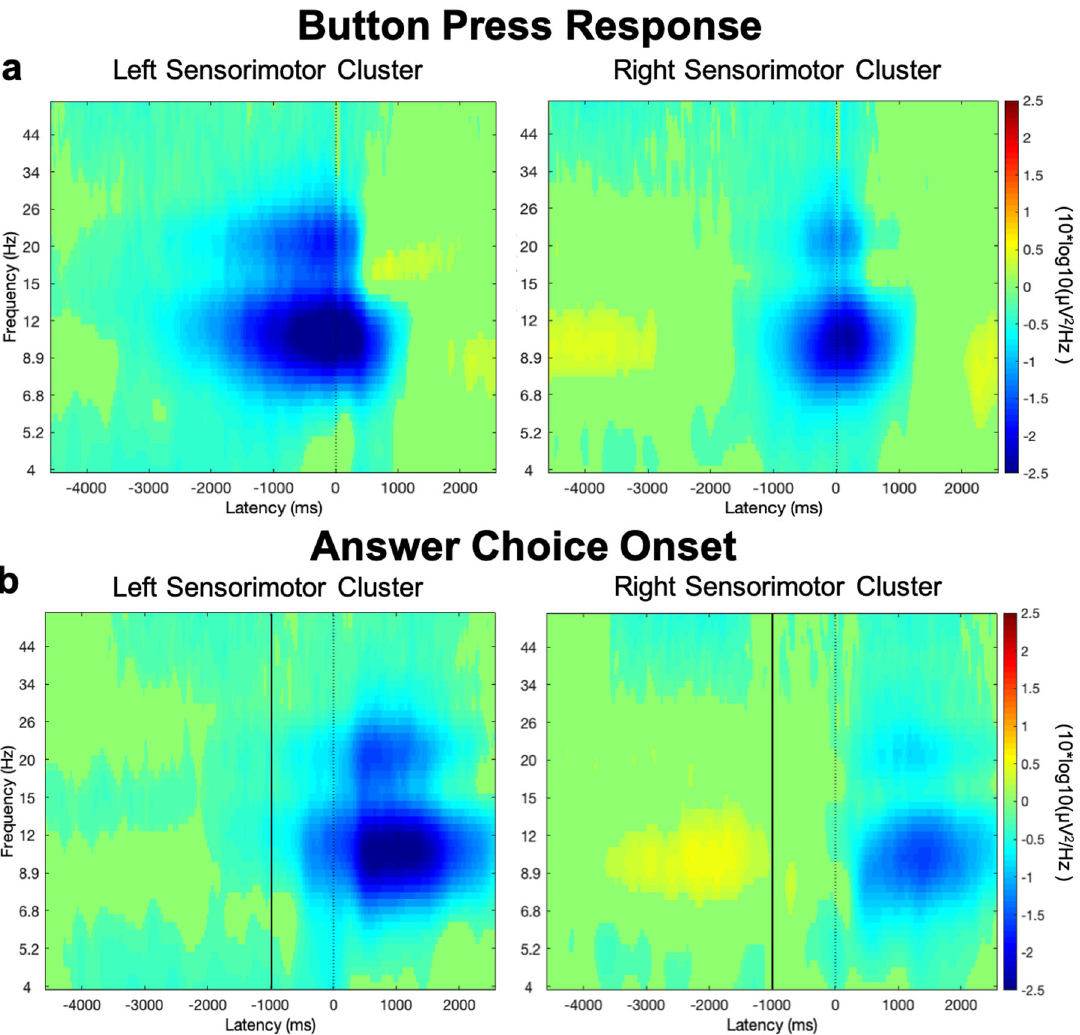
Fig. 5 EEG activity during motor response. In both hemispheres, the strongest response-associated activity appears within the µ and beta frequency ranges (8 – 30 Hz). All plots are baseline corrected at p < 0.001, FDR corrected. a EEG activity time-locked to the button press (dotted line). The button press occurs at variable latencies, so previous trial events (e.g. answer onset) are smeared across the pre-response period. b EEG activity time-locked to the onset of the answer choices (dotted line). The start of the silent post-stimulus waiting period occurs at − 1000 ms (solid line). The stimulus presentation window stretches from − 4000 ms to − 1000ms, and stimulus onset times vary across this window. In the left hemisphere, motor activity begins to ramp up − 500 ms prior to answer choice onset. In the right hemisphere, motor activity does not begin until after answer